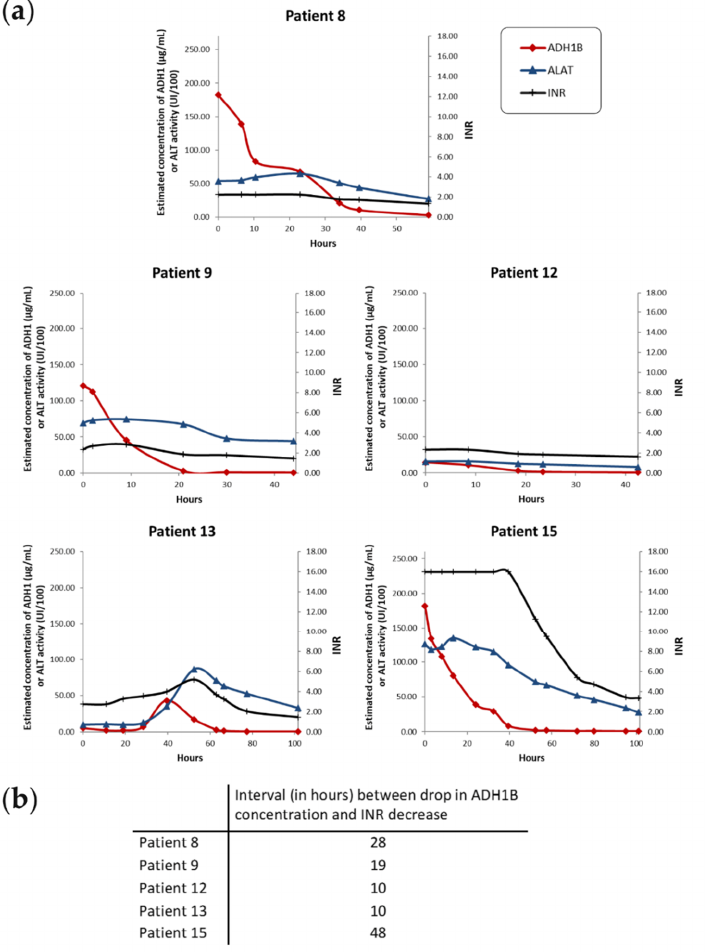
Figure 3. Time-dependent changes in liver injury biomarkers in five patients with acetaminophen- induced ALI/ALF. In these five patients who recovered spontaneously, ADH1B serum concentration started to decrease before the INR decreased. ( a ) Biological profiles for ALI/ALF patients who recovered spontaneously. ADH1B serum concentration was determined via quantitative LC–SRM. The INR indicates coagulation defects. Serum ALT activity is also indicated for comparison. Data points were connected using a smoothed line. ( b ) Interval between the earliest drop in ADH1B serum concentration after peaking and the decrease in the INR.